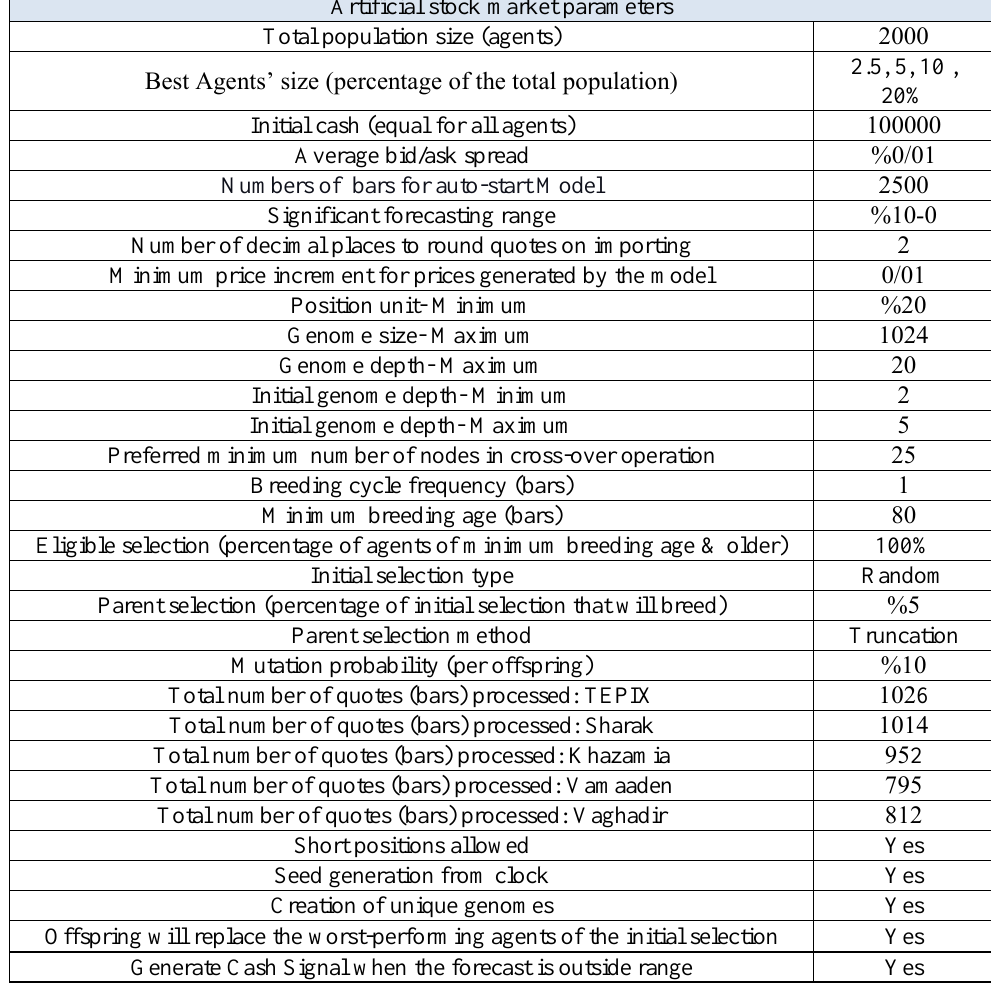
Table 1. Artificial stock market